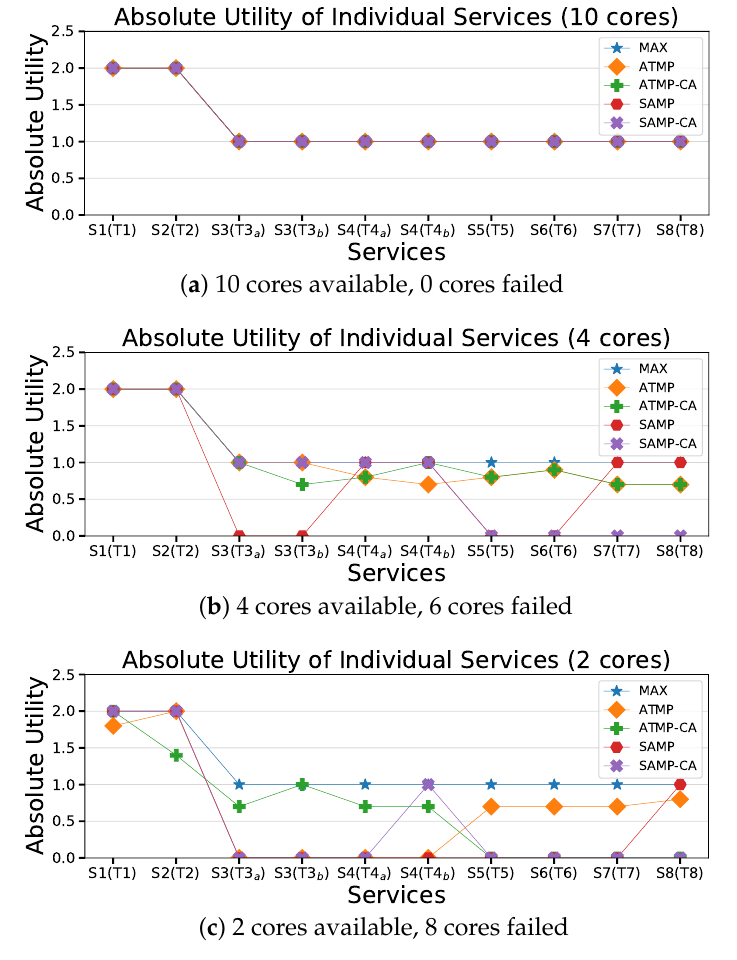
Figure 2. Experiment: absolute utility of individual services (replications: service S3 with tasks T 3 a and T 3 b , and service S4 with tasks T 4 a and T 4 b ); lines in graphs are visual guides only. This case represents the optimal allocation, which means that for each task, it was possible to assign them their primary period p prim , resulting in the maximum relative utility of 1.0, and no service was